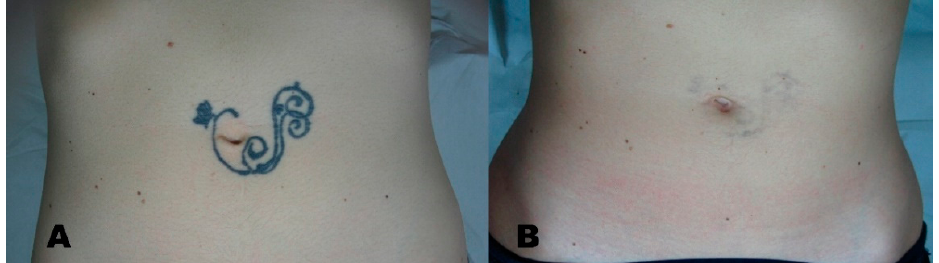
Figure 5. ( A ) Picture before starting tattoo removal treatment, and ( B ) the same region at the 6-month follow-up, after all tattoo removal sessions had been completed.